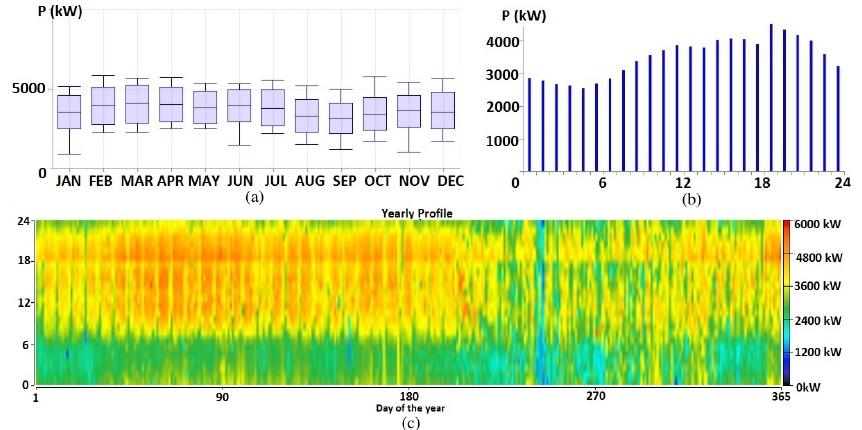
Figure 4. Existing loads in Santa Cruz, Galapagos: ( a ) box and whisker plot of monthly profiles; ( b ) annual load intensity plot; ( c ) example of a daily profile